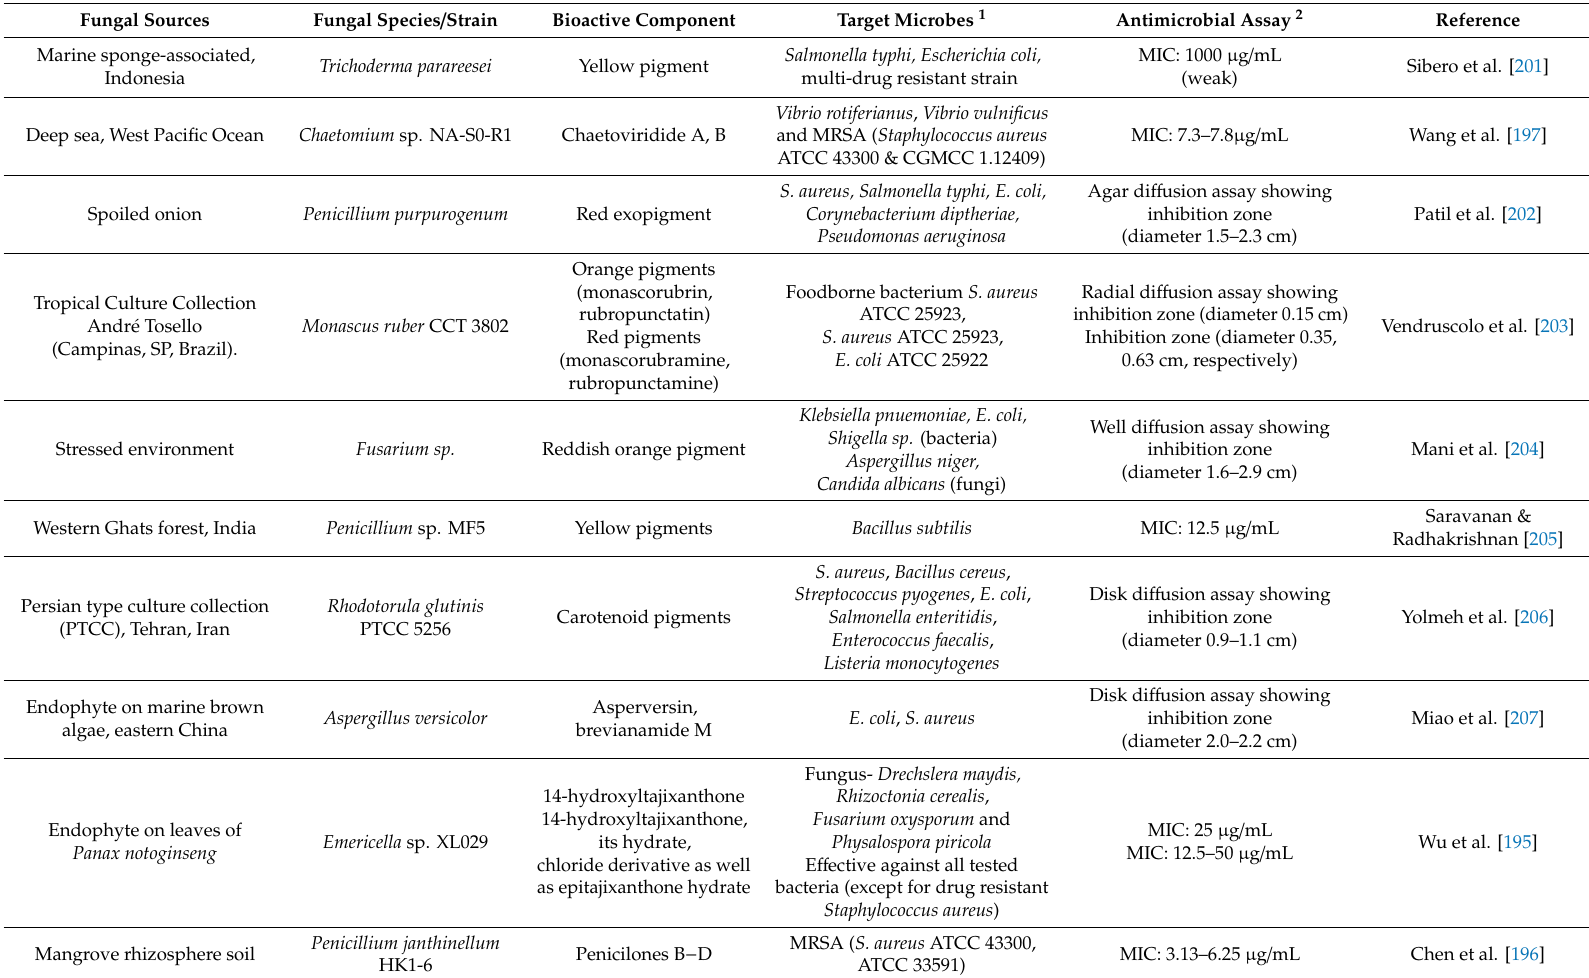
Table 2. Antimicrobial activities of fungal